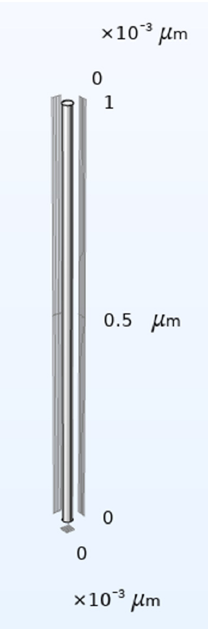
Figure 3. Geometry of the numerical domain.